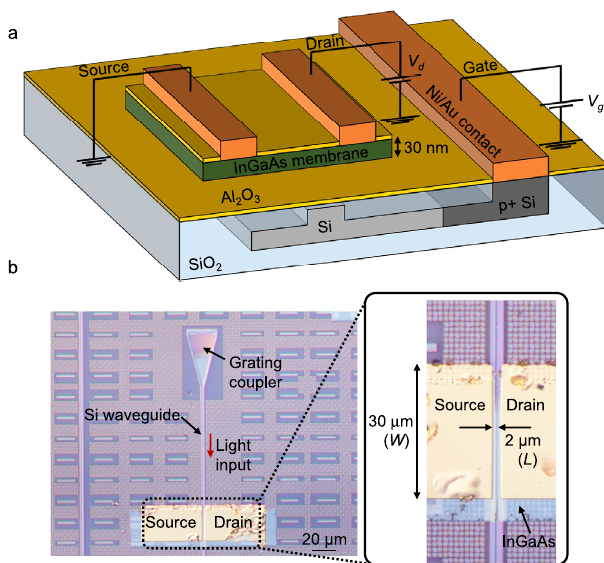
Fig. 1 | Schematic and images of a fabricated waveguide-coupled photo- transistor. a 3D view of the phototransistor consisting of a 30nm-thick InGaAs membrane on the Si waveguide back gate with an Al 2 O 3 gate dielectric. The Ni/Au metal source and drainareformed on the InGaAschannel. b Plan-viewmicroscopy imagesofthefabricateddevice.Anopticalsignalata1.3 μ mwavelengthiscoupled to the Si waveguide through the grating coupler. The gate length and width are 2 μ m and 30 μ m,